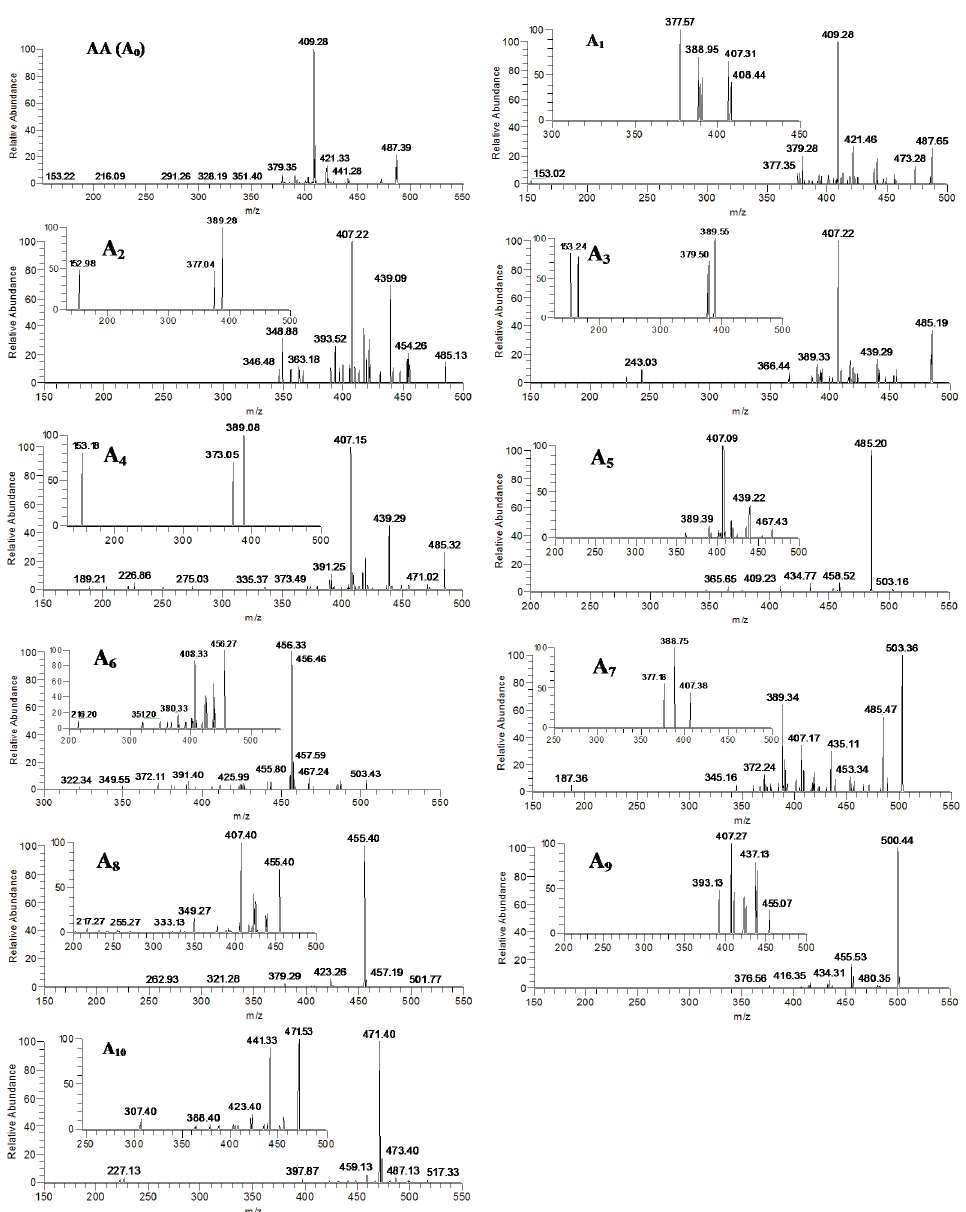
Figure 3. The MS n ( n = 2–3) spectra of the metabolites (A 0 –A 10 ) of asiatic acid after zebrafish exposure: A 0 ( m / z 487); A 1 ( m / z 487, m / z 487 → 409), A 2 , A 3 and A 4 ( m / z 485, m / z 485 → 407 ); A 5 ( m / z 503, m / z 503 → 485); A 6 ( m / z 503, m / z 503 → 457); A 7 ( m / z 503, m / z 503 → 407); A 8 and A 9 ( m / z 501, m / z 501 → 455); and A 10 ( m / z 517, m / z 501 →